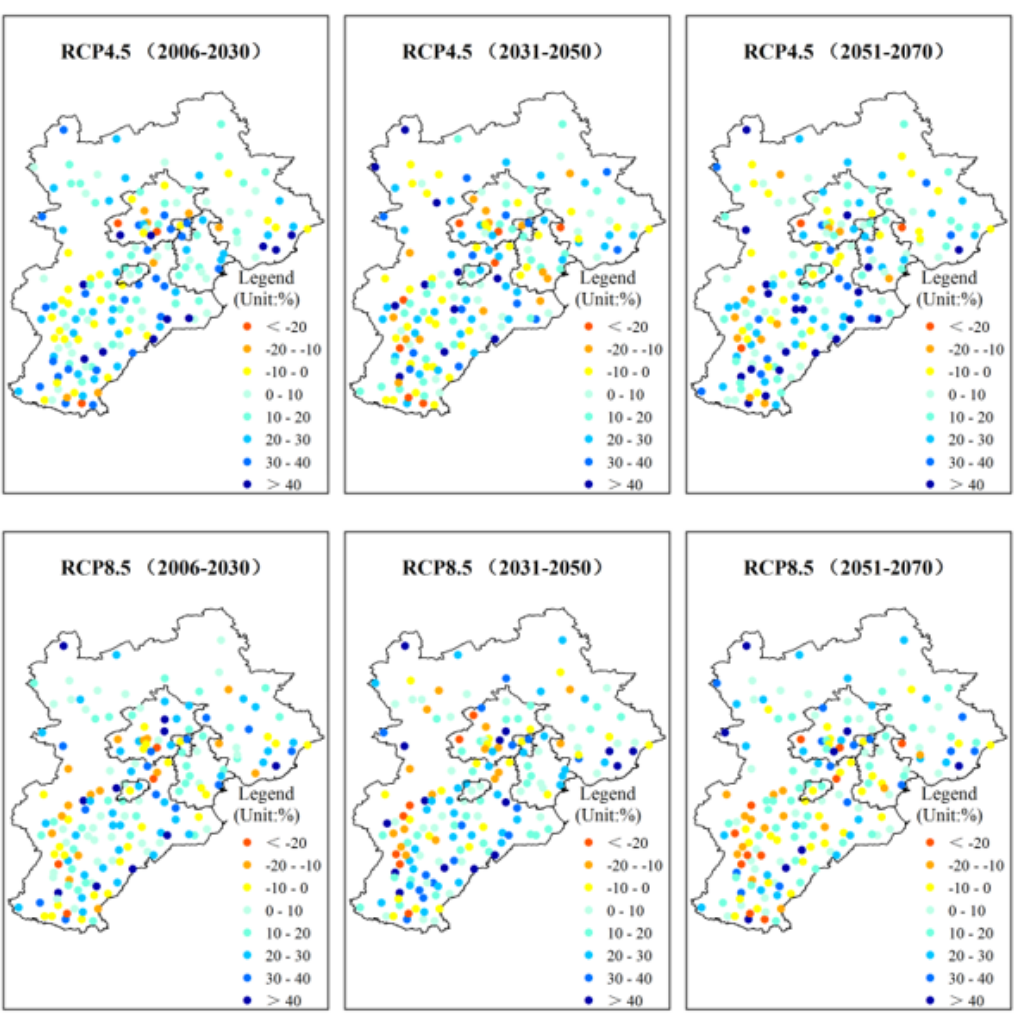
Figure 7. Spatial distribution of annual percentage changes of Px5d across the Beijing-Tianjin-Hebei region during 2006–2030, 2031–2050, and 2051–2070 compared with 1961 – 2005.